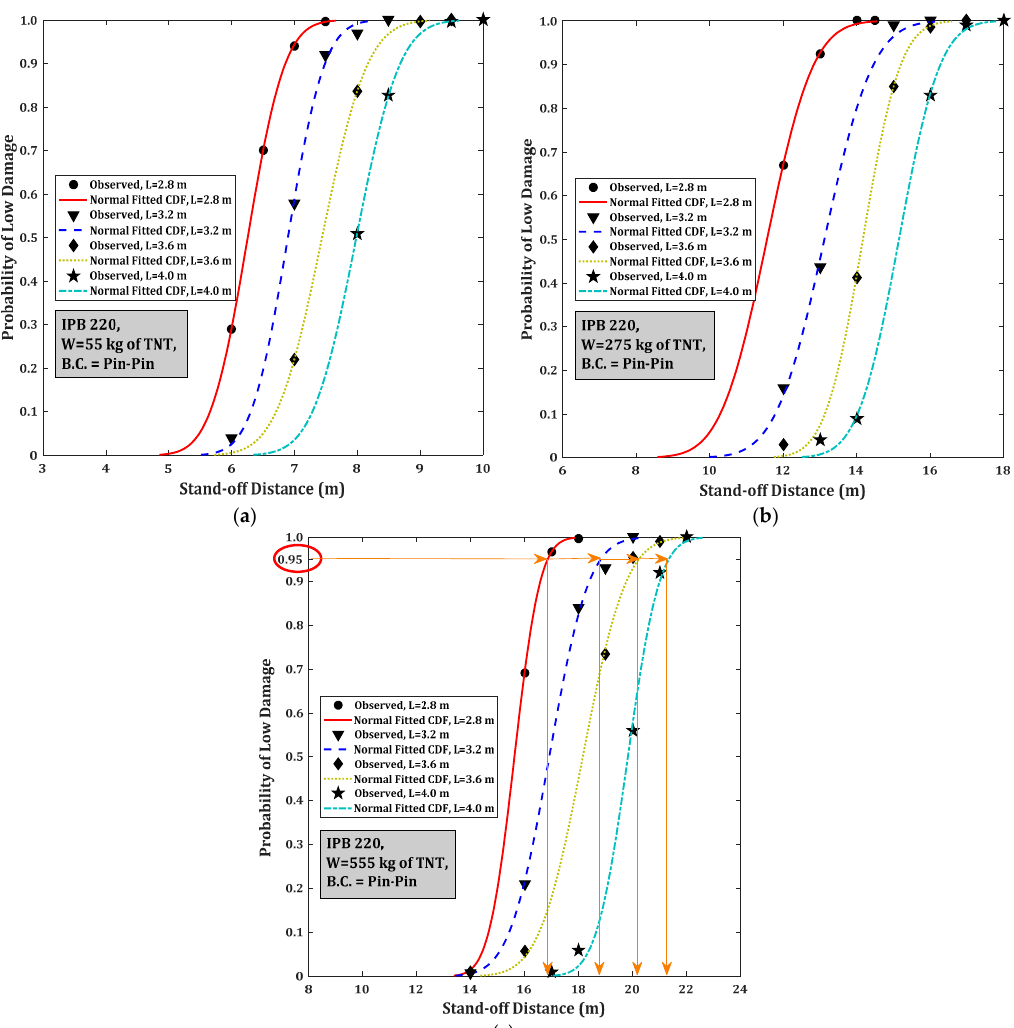
Figure 6. Curves of probability of low damage for IPB220 with pinned ends and different lengths subjected to: ( a ) 55, ( b ) 275 and ( c ) 555 kg of TNT.